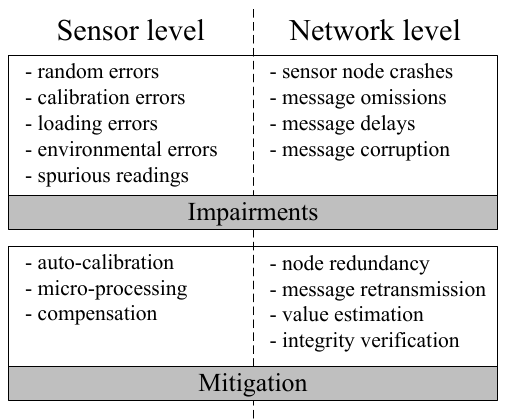
Figure 1. Generic view of the WSN-based monitoring system.